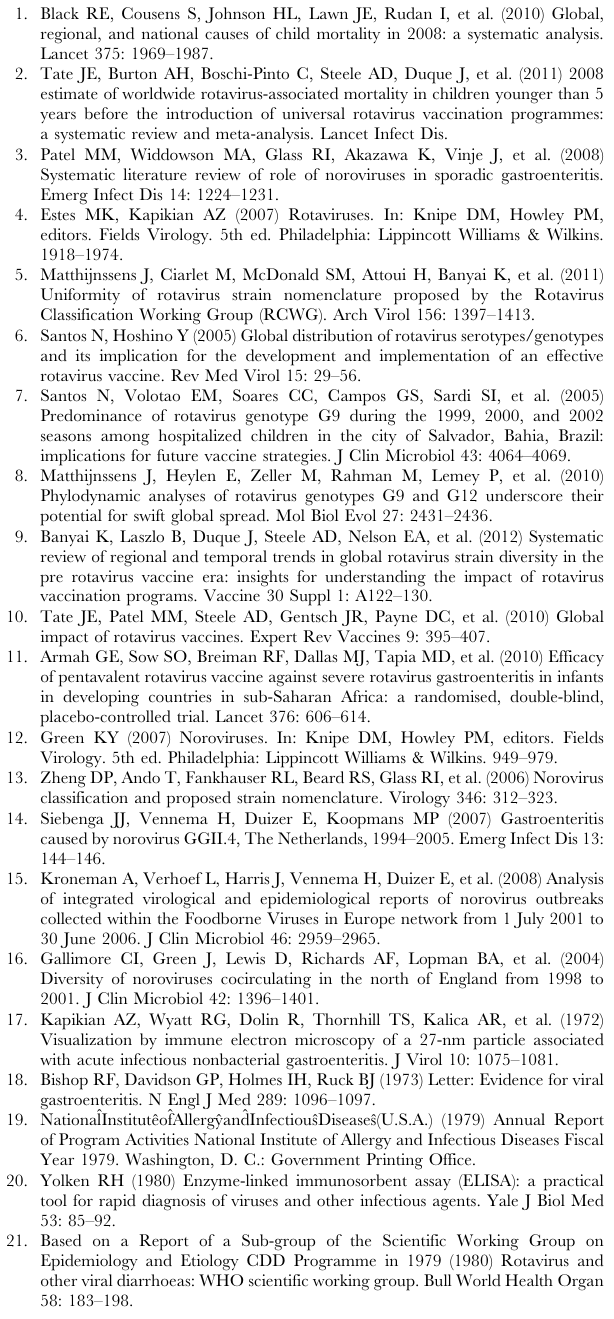
Table S3 Sequences of Norovirus VP1 Genes for Bayesian Phylogenetic Analysis of GI.1 and GI.3 Noroviruses. (DOCX) Text S1 Detailed Description of the Rotavirus VP7 and VP4 Genotyping Reactions Used in this Study.